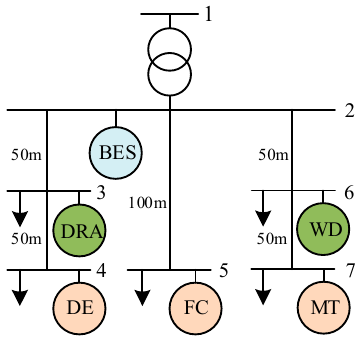
Figure 3. Topology of the MG.